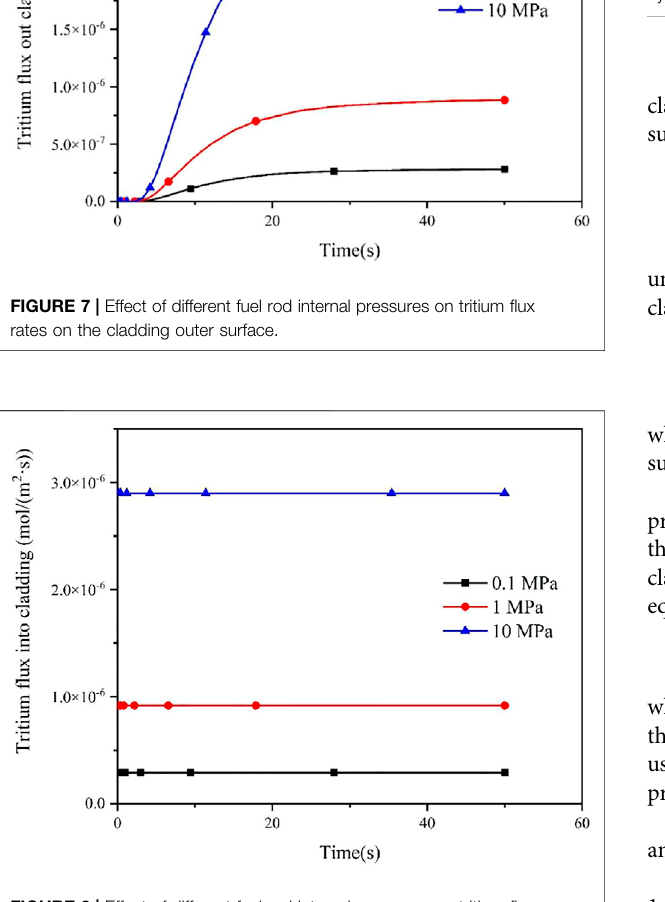
FIGURE 8 | Effect of different fuel rod internal pressures on tritium fl ux rates on the cladding inner surface.